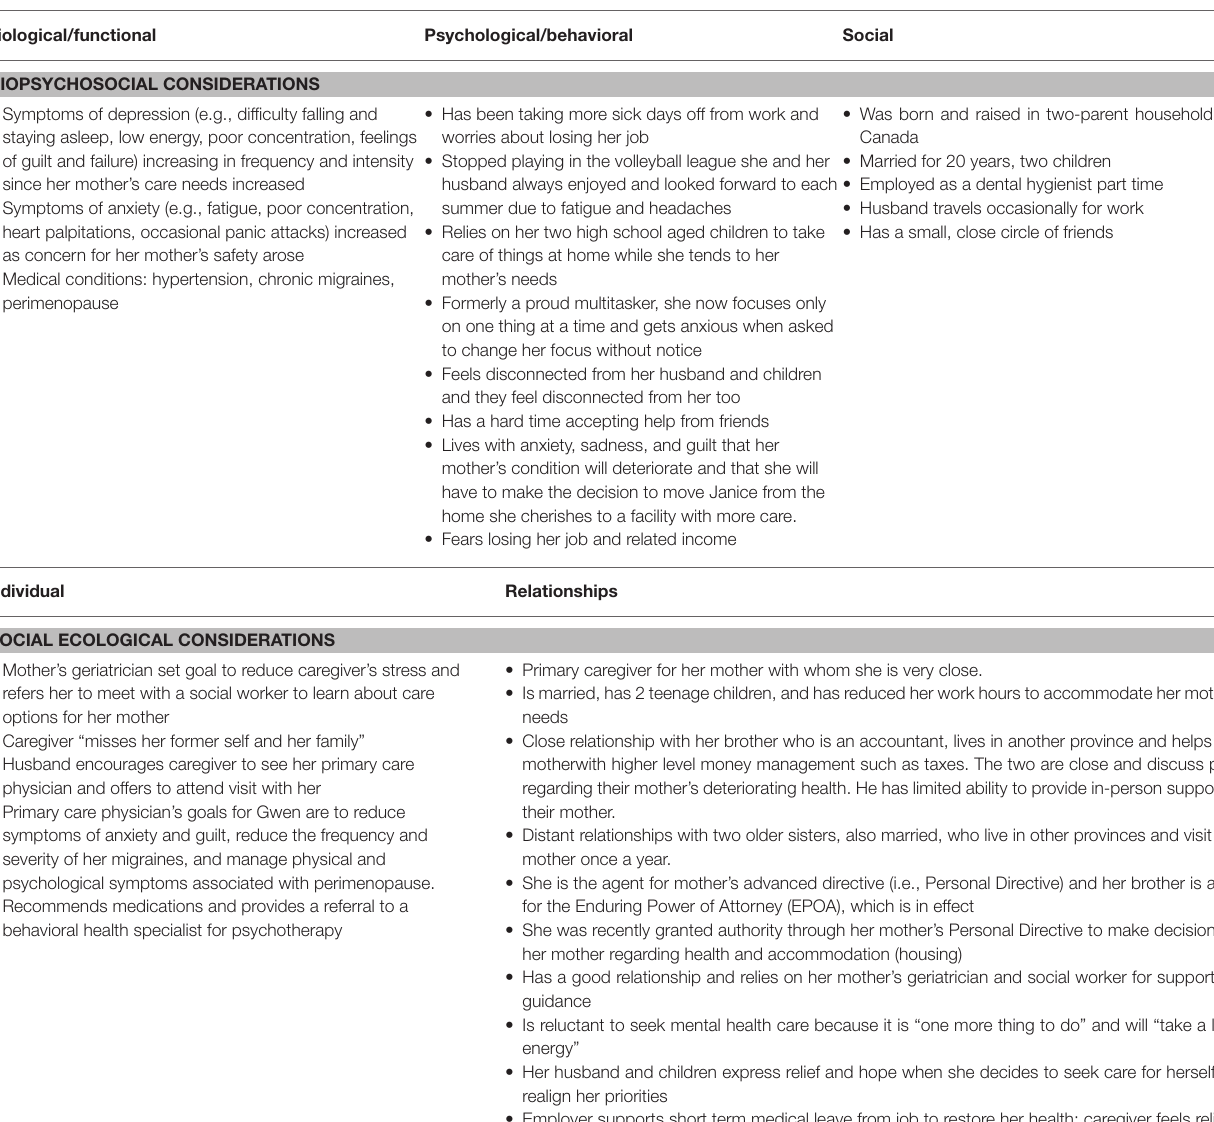
TABLE 1B | Examples of biopsychosocial and social ecological considerations for a family caregiver: the case of Gwen. Identifying Information: Gwen is a married 45 year old woman with two children, a job, and responsibilities as primary caregiver for her 85 year old mother with advanced dementia who lives nearby in Canada Reason for Assessment: Caregiver stress